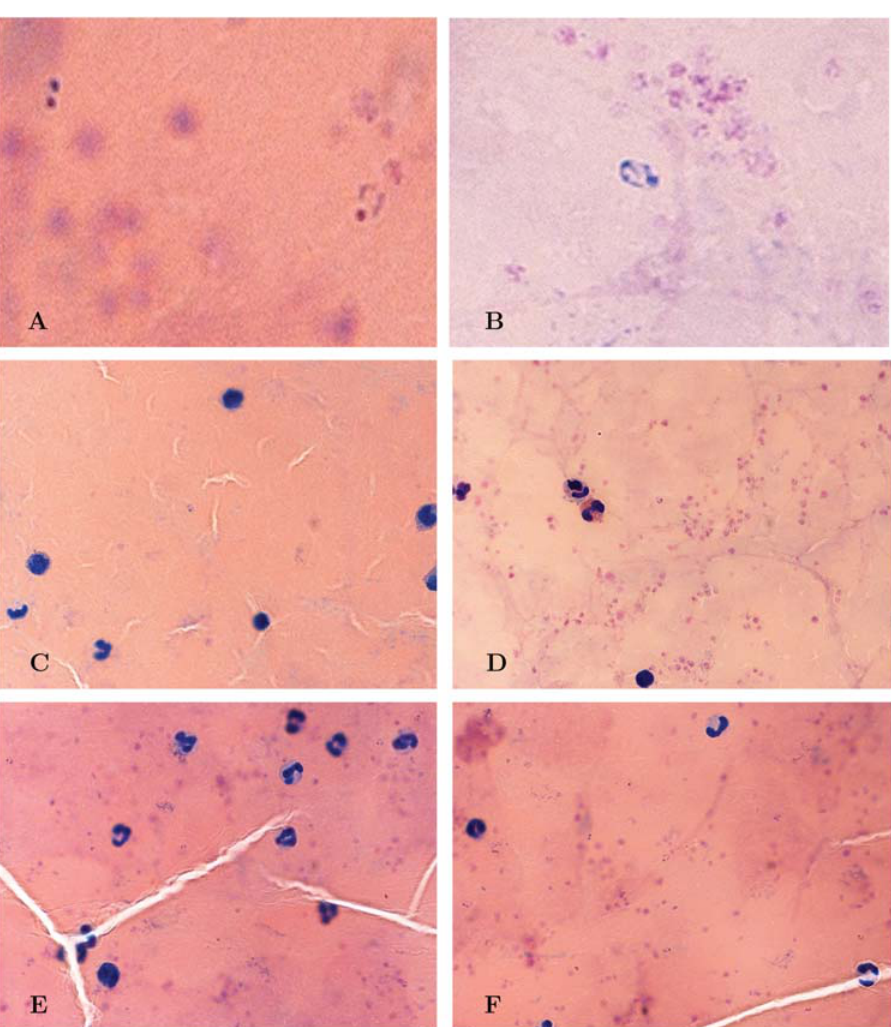
Figure 9. Normal parasites and crisis forms. Crisis forms differ from normal parasites in their slightly more ‘ragged’ morphology and altered staining of the nuclear material-live parasites have nuclei that stain red/blue, these abnormal parasites lose all red chromatin staining. Magnified high power images are shown in A&B. Normal parasites are seen in Figure 9A, whilst 9B shows a film containing a crisis form. The remaining films are unmagnified and white blood cell nuclei are clearly visible in blue, with smaller headphone shaped parasites. Figure 9C & D show single crisis forms, whilst 9E & F show multiple normal parasites, with the characteristic red/blue nuclear staining.